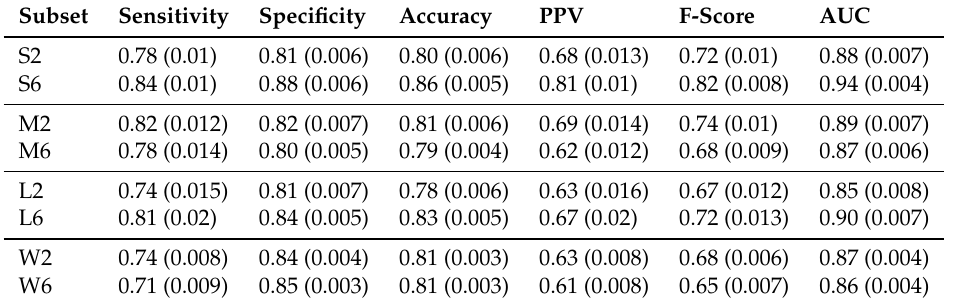
Table 7. Predictive performance of generalised linear model based on the estimated sensitivity, specificity, accuracy, positive predictive value (PPV), F-score and the area under receiver operating characteristic curve (AUC) for two-week and six-week restriction periods among the cows in early (S), mid (M) and late (L) lactation stage using cross validation studies.